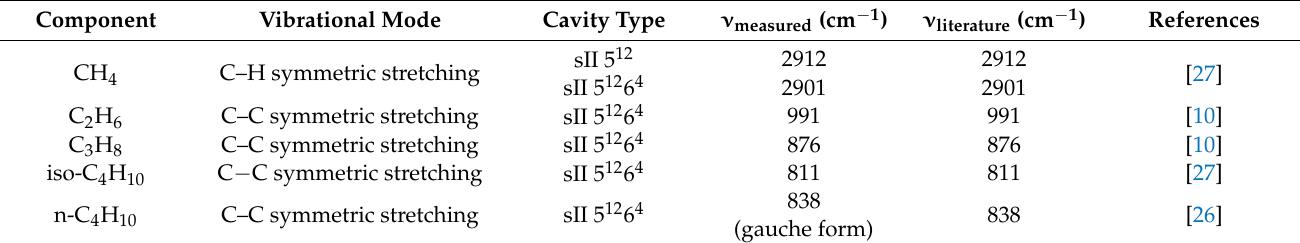
Table 1. Assignments of measured Raman bands based on literature